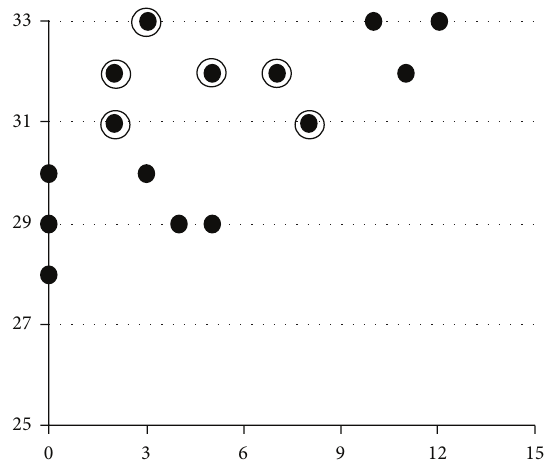
Figure 3: Vigilance (MoCA) and ASA task. ASA: auditory selective attention. The horizontal line shows the ASA task (60 db) scores and the vertical line indicates the vigilance test scores. For both tests, higher scores mean better performances. There was a significant Spearman’s correlation (Rs = 0.611, 𝑃 < 0.01 ) between the scores. Double circles mean donepezil